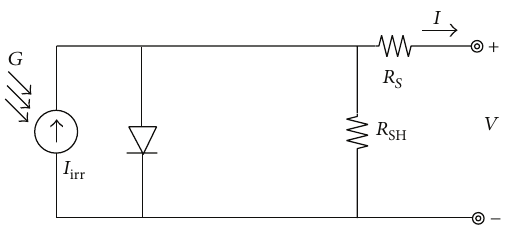
Figure 1: One-diode equivalent model for a PV